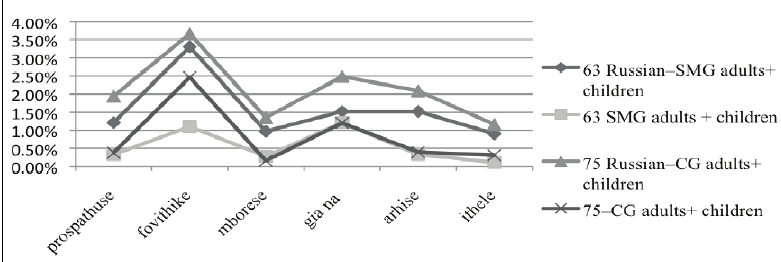
Figure 1: Types of main verbs